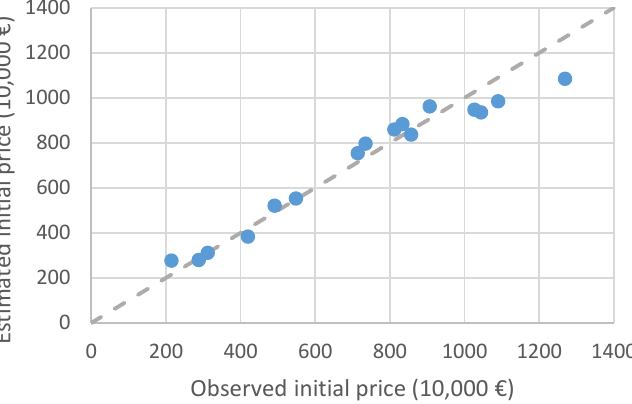
Figure 4. Observed versus estimated initial price using the non-linear initial unit price model.